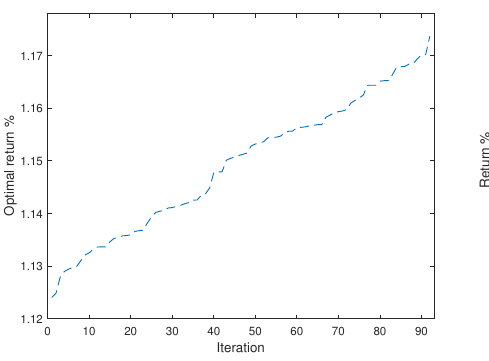
(b) The return of optimal portfolio by ε BBO in each period with benchmark portfolio and the optimal portfolio by SA and LF algorithm Figure 2. The performance of the ε BBO and the optimal portfolio in X ∈ [ 0,0.6 ] of model (28).